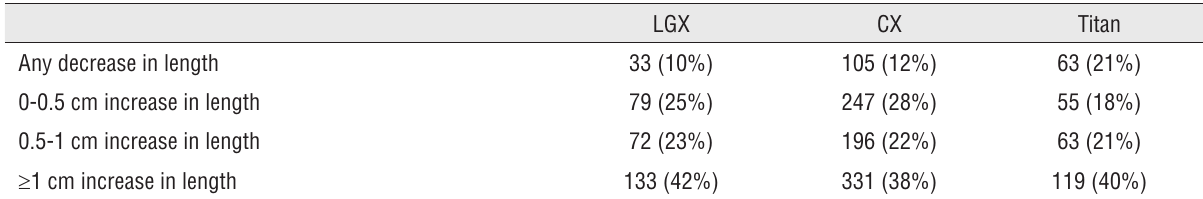
Table 2 - Interval Changes in Cylinder Length for AMS 700 LGX, AMS 700 CX, and Coloplast Titan with Device Replacement at ≥ 2